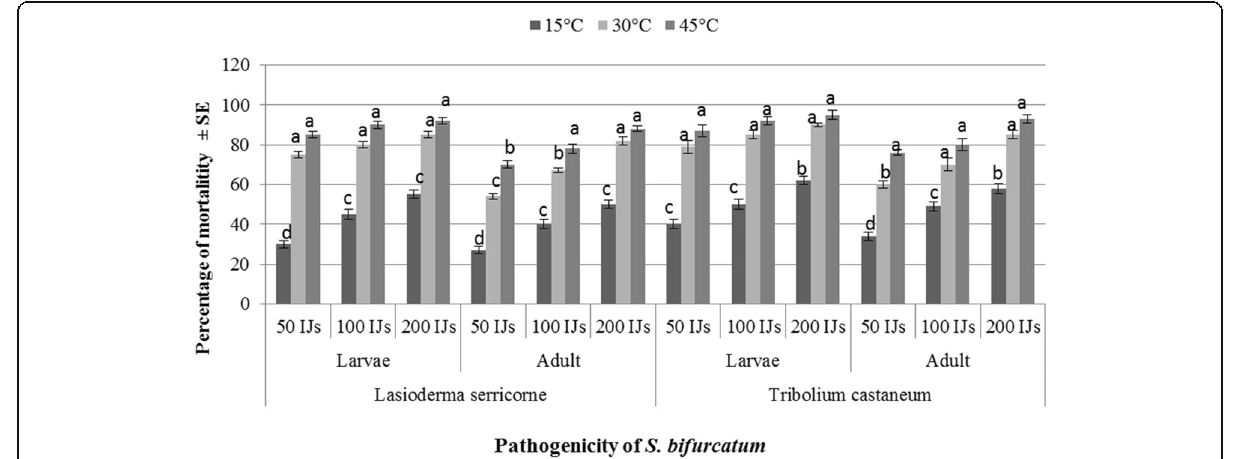
Fig. 1 Percentage mortality of insects at three different concentrations and temperatures inoculated by Steinernema bifurcatum